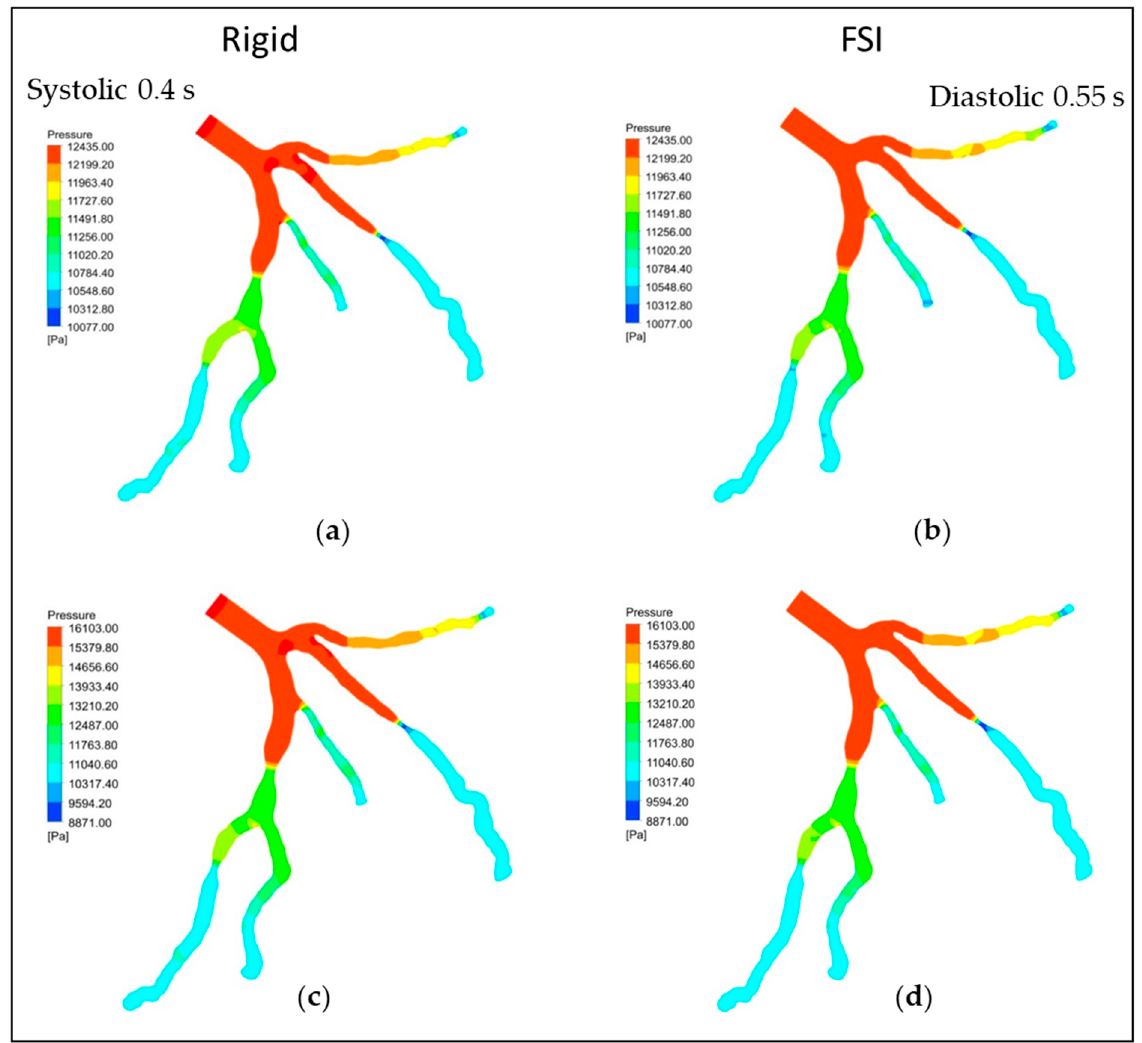
Figure 6. Wall pressure field in left coronary artery during the systolic and diastolic phase of cardiac cycle for ( a , c ) Rigid and ( b , d ) FSI models.